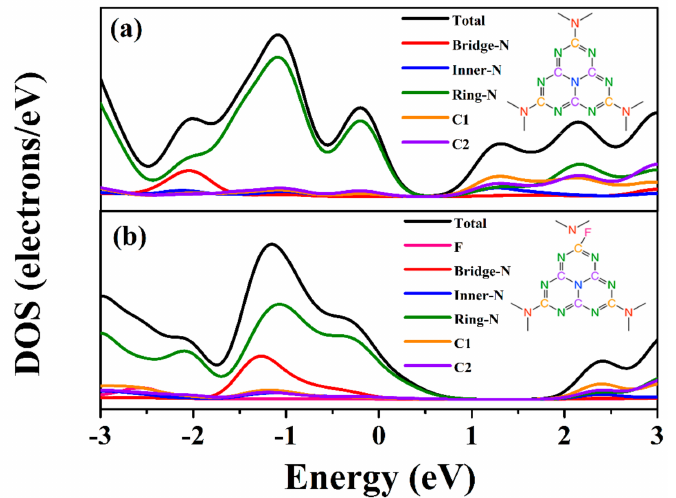
Figure 7. Calculated density of state (DOS) values for ( a ) g-C 3 N 4 and ( b ) F-g-CN from their optimized